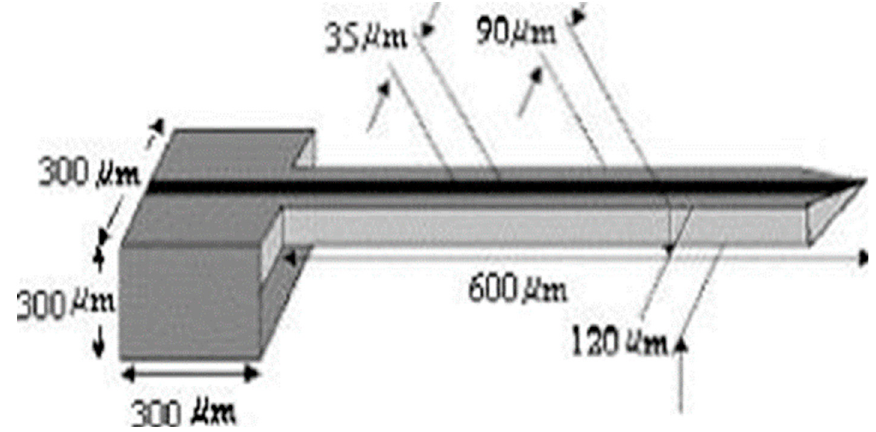
Figure 7. Relationship between skin and MN design parameters and therapeutic efficacy.